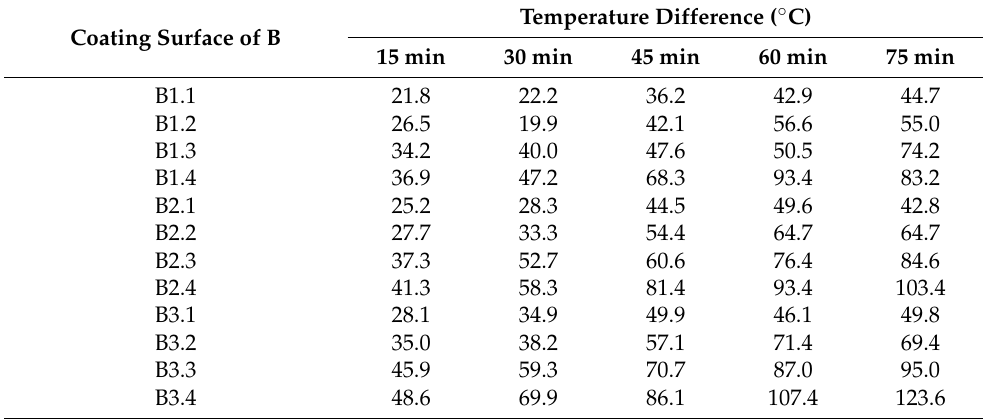
Table 5. The temperature difference between the surface of SUS304 and the coating surface of B.